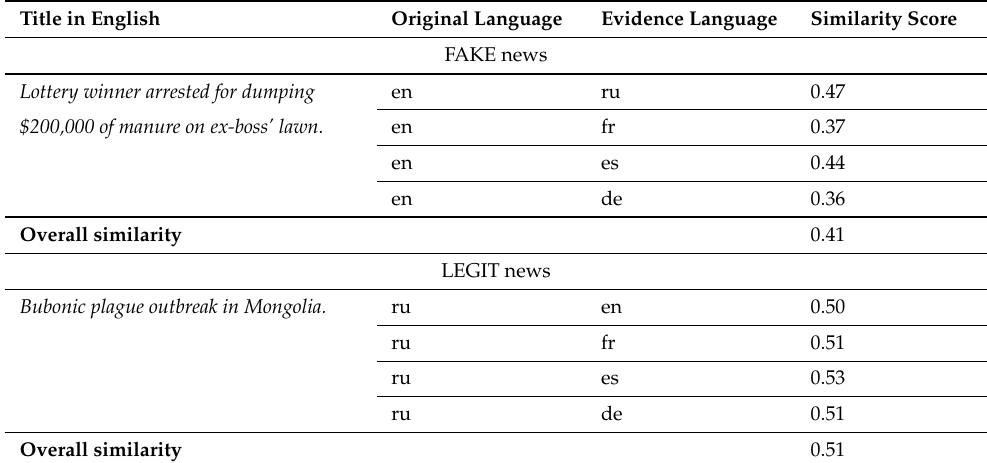
Table 7. Results of the cross-lingual image comparison: “anecdotal evidence” suggesting that this line of work may be worth further